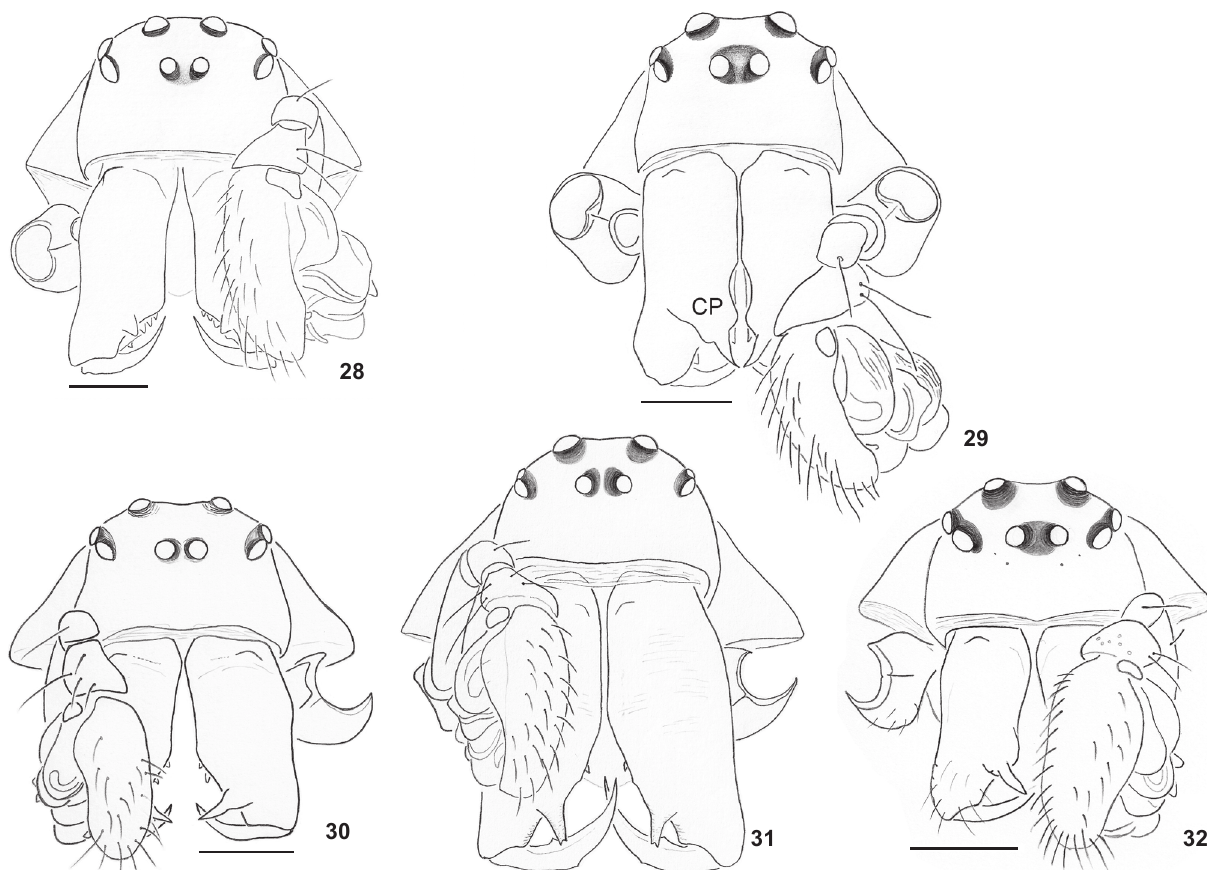
Figures 28-32. Cephalothorax, frontal view: (28) Eurymorion nobile ; (29) E. insigne ; (30) E. murici sp. nov. ; (31) E. mourai sp. nov.; (32) E. triunfo sp. nov. (CP) Cheliceral process. Scale lines: 0,5